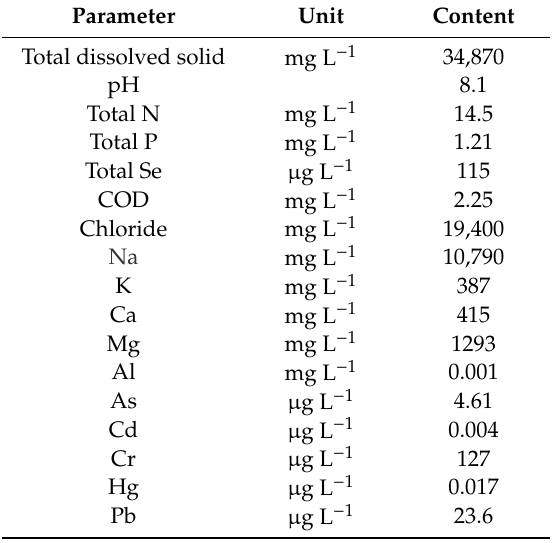
Table 1. Characteristics of the raw aquaculture wastewater.